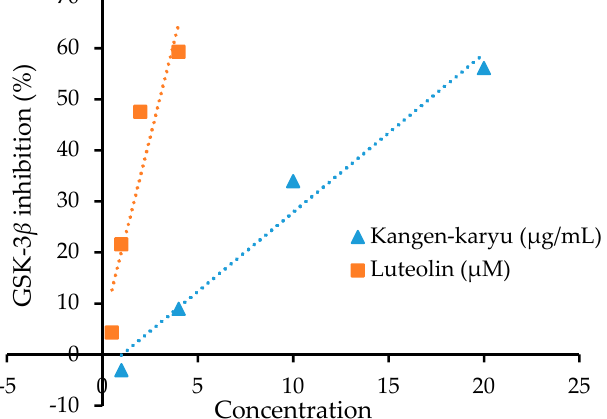
Figure 2. Linear graph of IC 50 for glycogen synthase kinase-3 β inhibition by water extract of Kangen-karyu and luteolin.